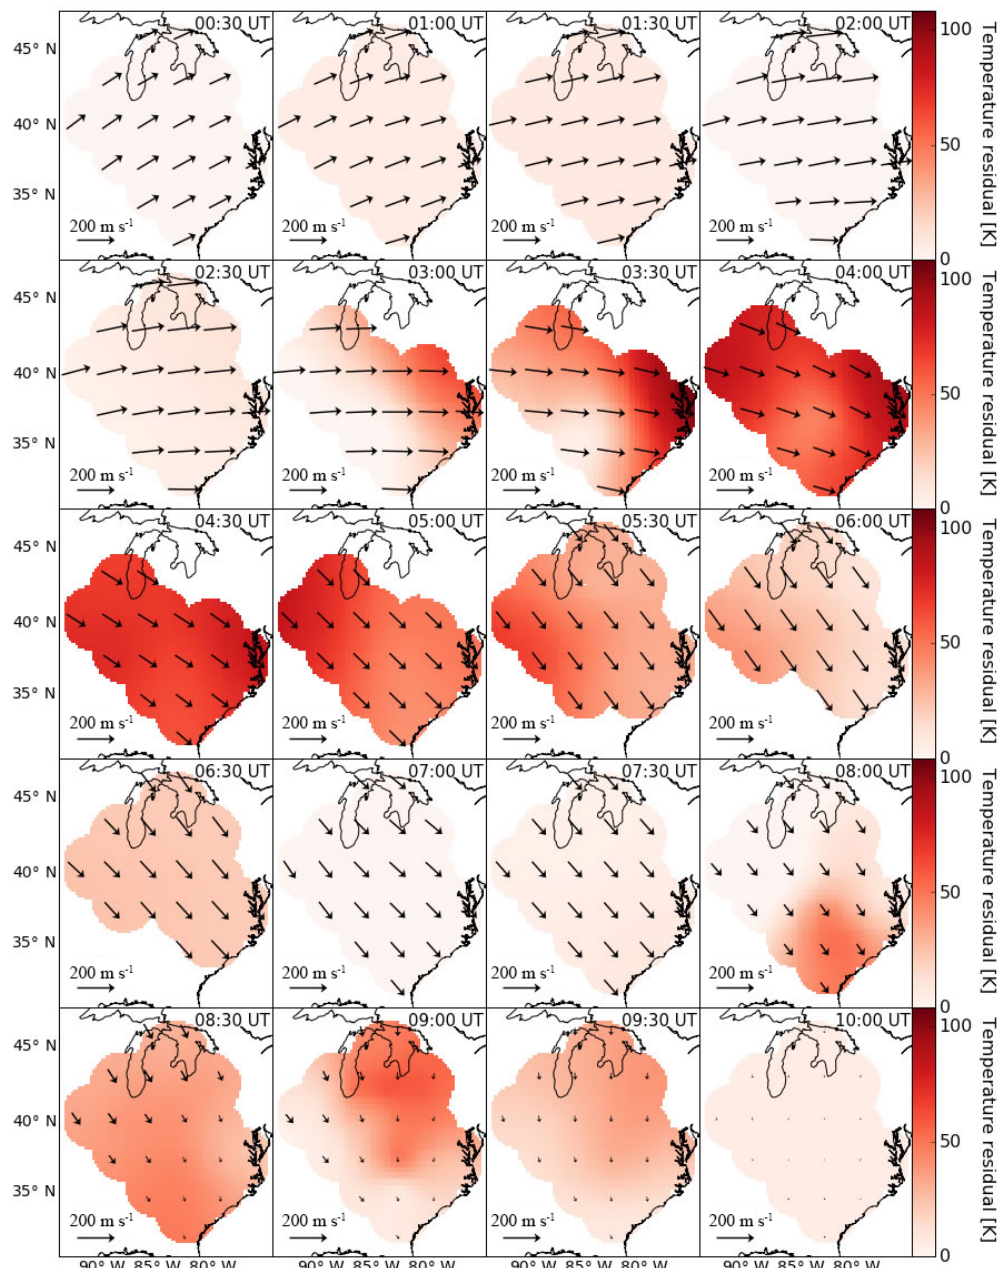
Figure 6. 2-D temperature maps generated from the measurements with the harmonic thermal background removal technique for the night of 28 December 2013. Two clear MTM events are seen as suggested by the modeling work of Akmaev et al. (2009). The gray-shaded map represents the approximate local midnight in the middle of the NATION